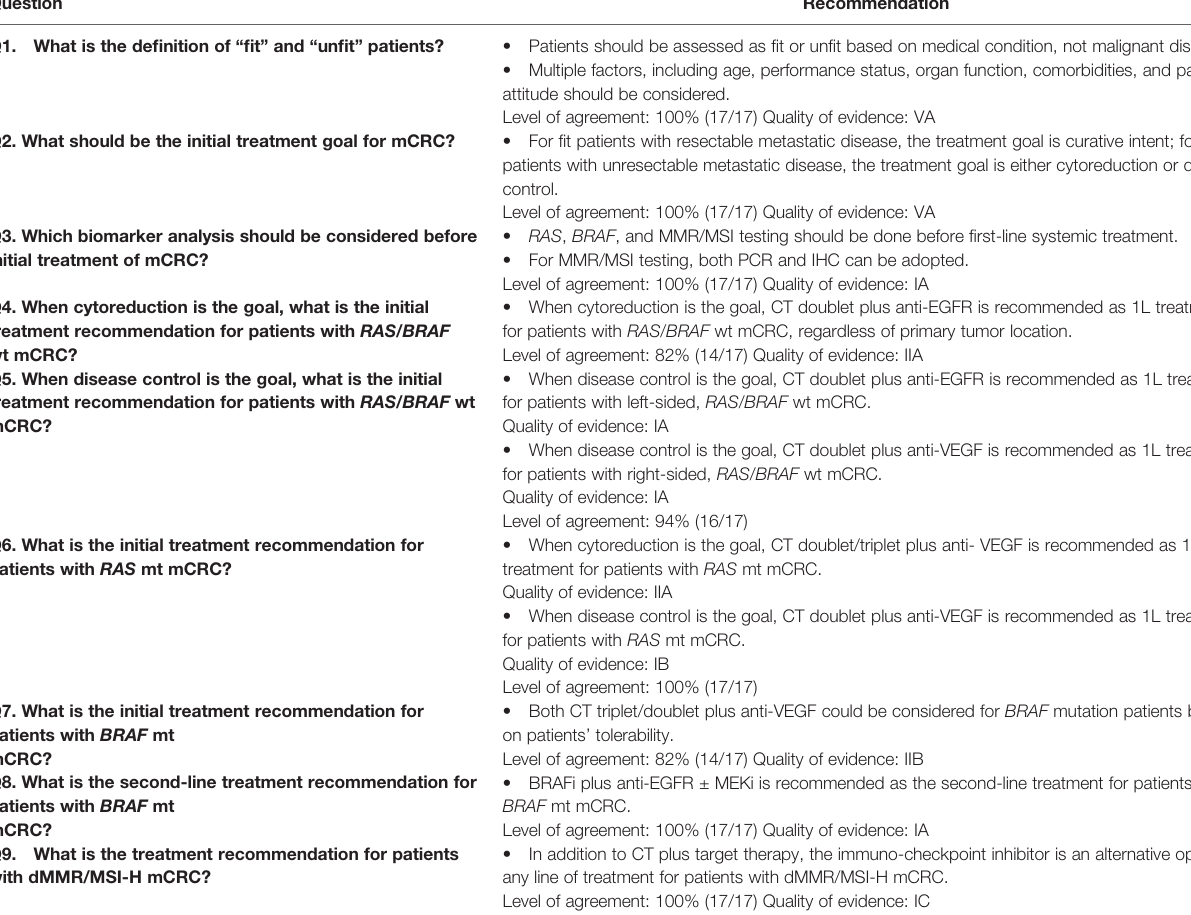
TABLE 2 | Summary of